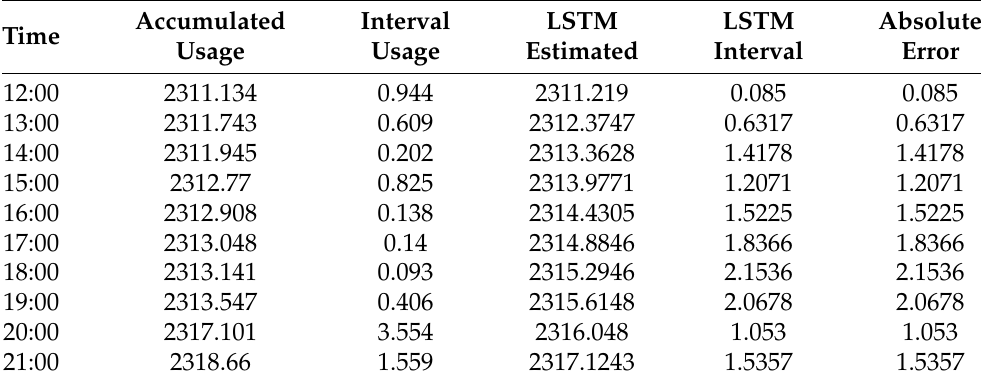
Table 8. Data corrected based on the LSTM